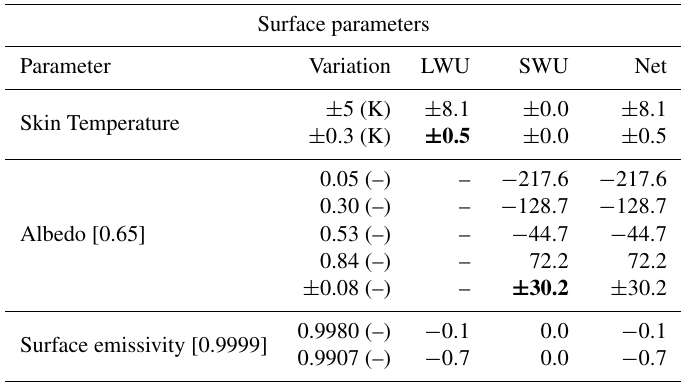
Table A4. The table indicates the mean upward SW (SWU), LW (LWU), and net flux differences at the top of the atmosphere (TOA) of clear-sky (CS) perturbed simulations minus idealized atmosphere simulation. Values in Wm − 2 . Values highlighted in bold are used as uncertainties.